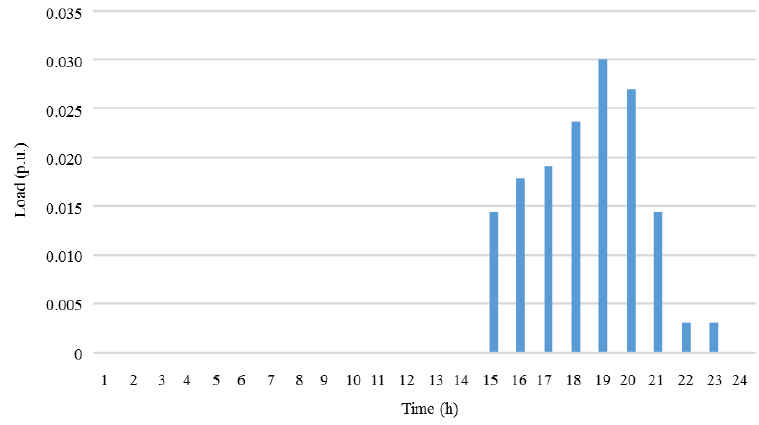
Figure 10. Load demand profile for Case 3 (30 EVs, uncontrolled charging).